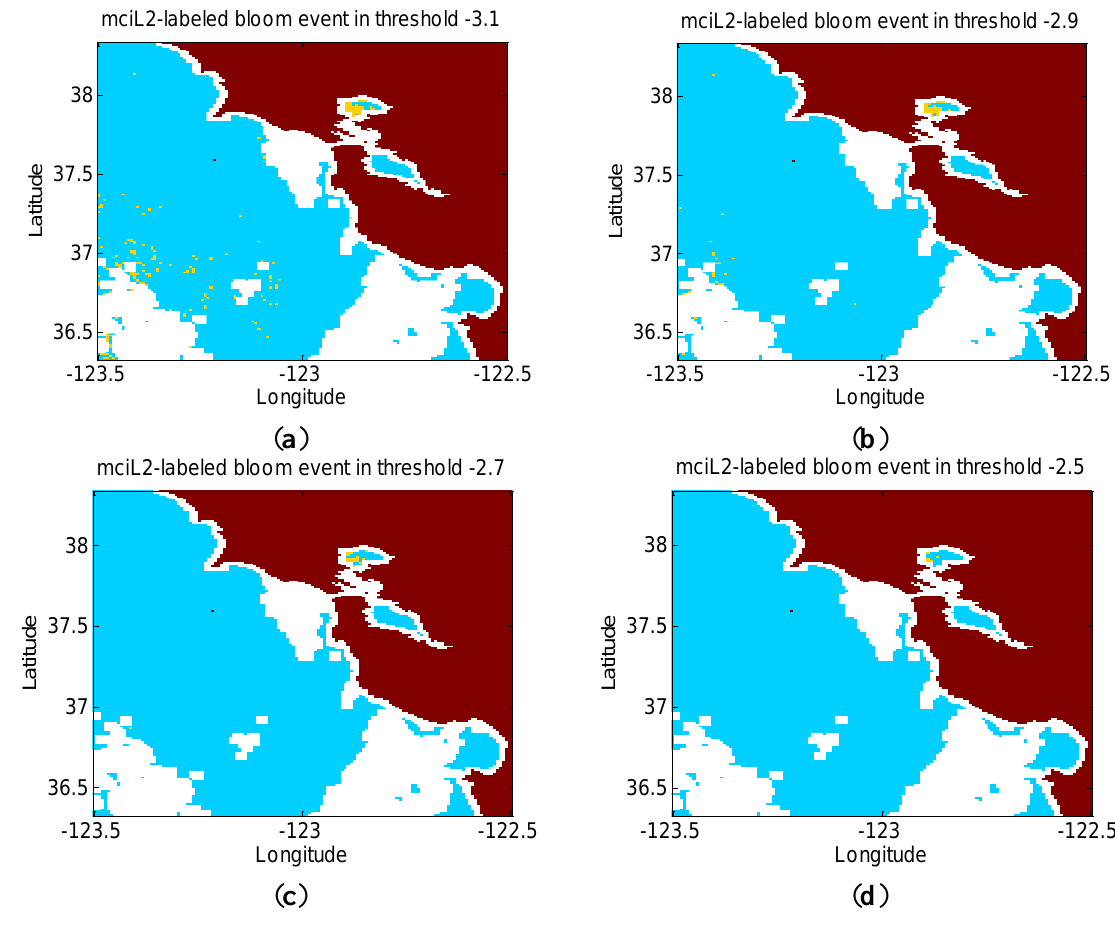
Figure 4. MCI-based bloom phenomenon appearance test using various thresholds on 31 January 2011. The MCI thresholds are at the top of each subfigure ( a – d ). Yellow means HAB, red means land, blue represents ocean without HAB, and white means no